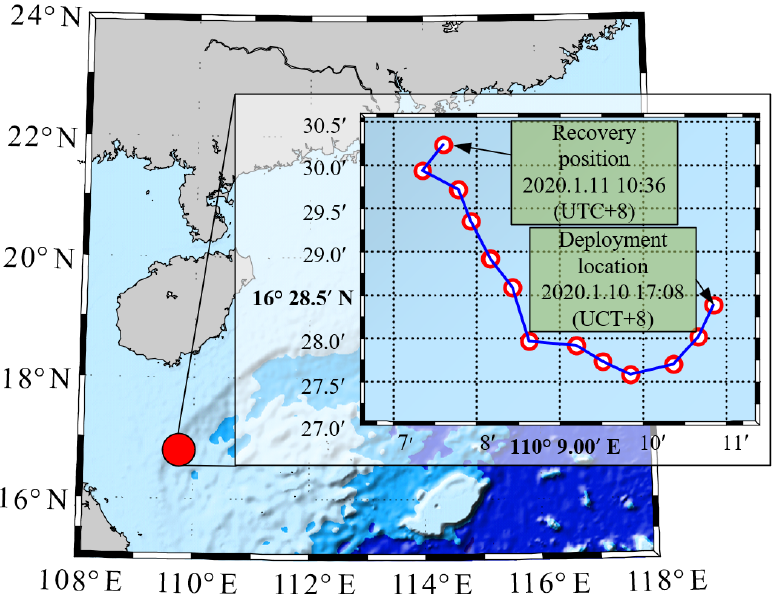
Figure 3. Deployment location and glide path of DHUG in the South China Sea, with the red circle indicating its valid GPS position when it floats on the surface.